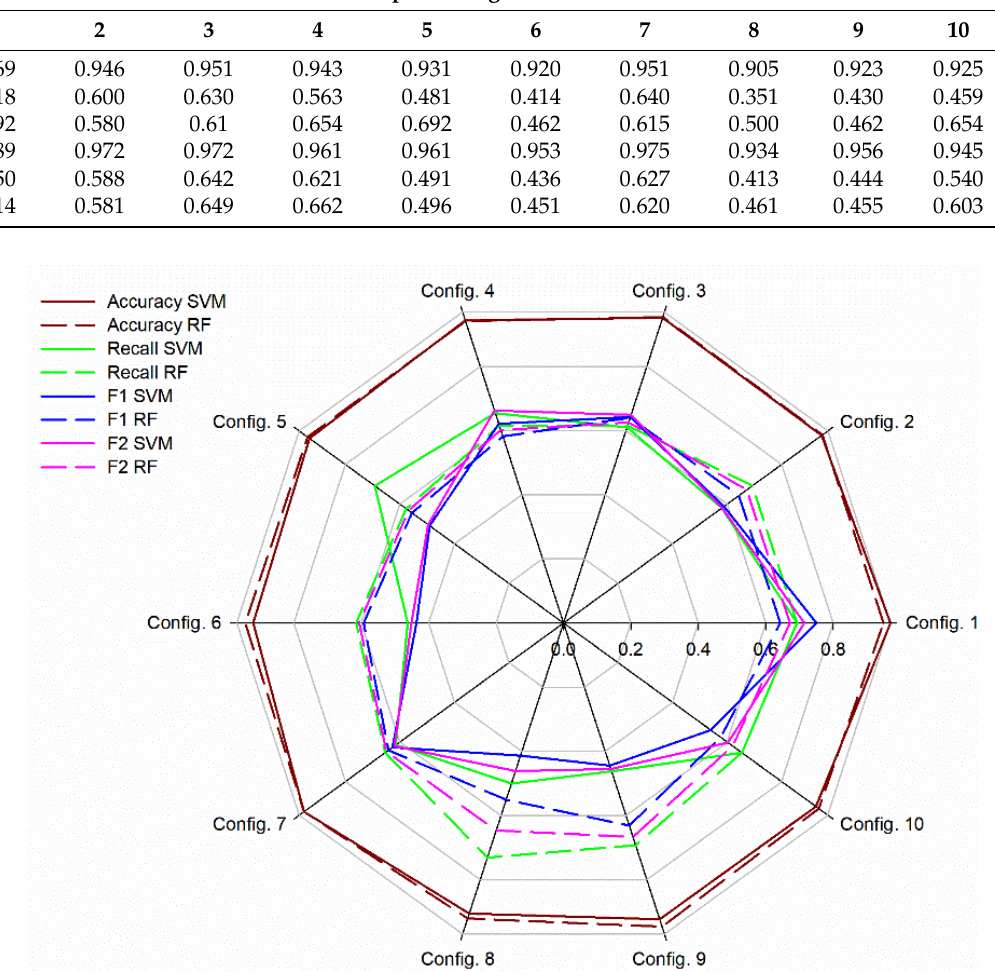
Figure 2. Comparison of SVM and RF models’ performance metrics with different input configura- tions for the oversampling-based balanced datasets and T = 10 days.